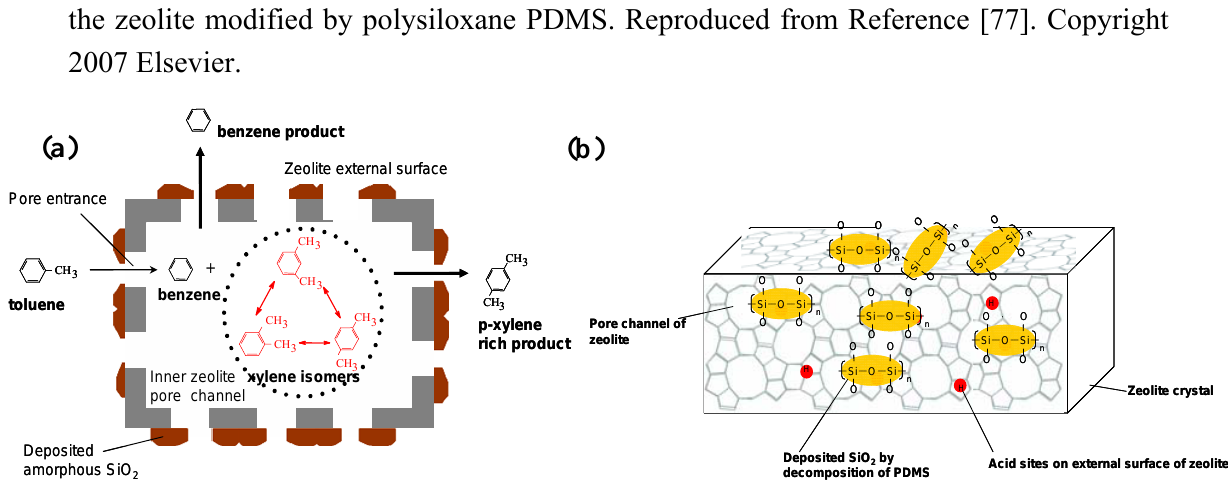
Figure 1. (a) Scheme of selective toluene disporportionation reaction on amorphous silica decorated zeolite composite catalysts; (b) illustration of the external surface active sites of the zeolite modified by polysiloxane PDMS. Reproduced from Reference [77].